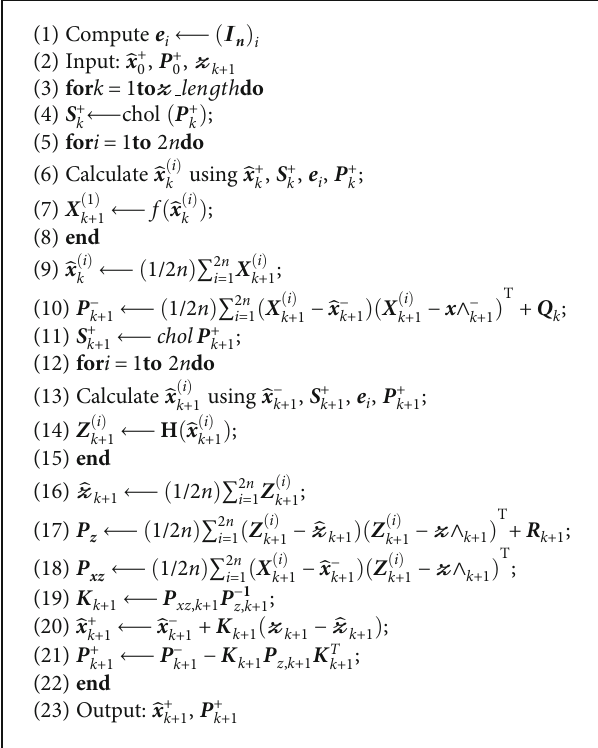
Algorithm 2:Pseudocode of the cubature Kalman fi lter